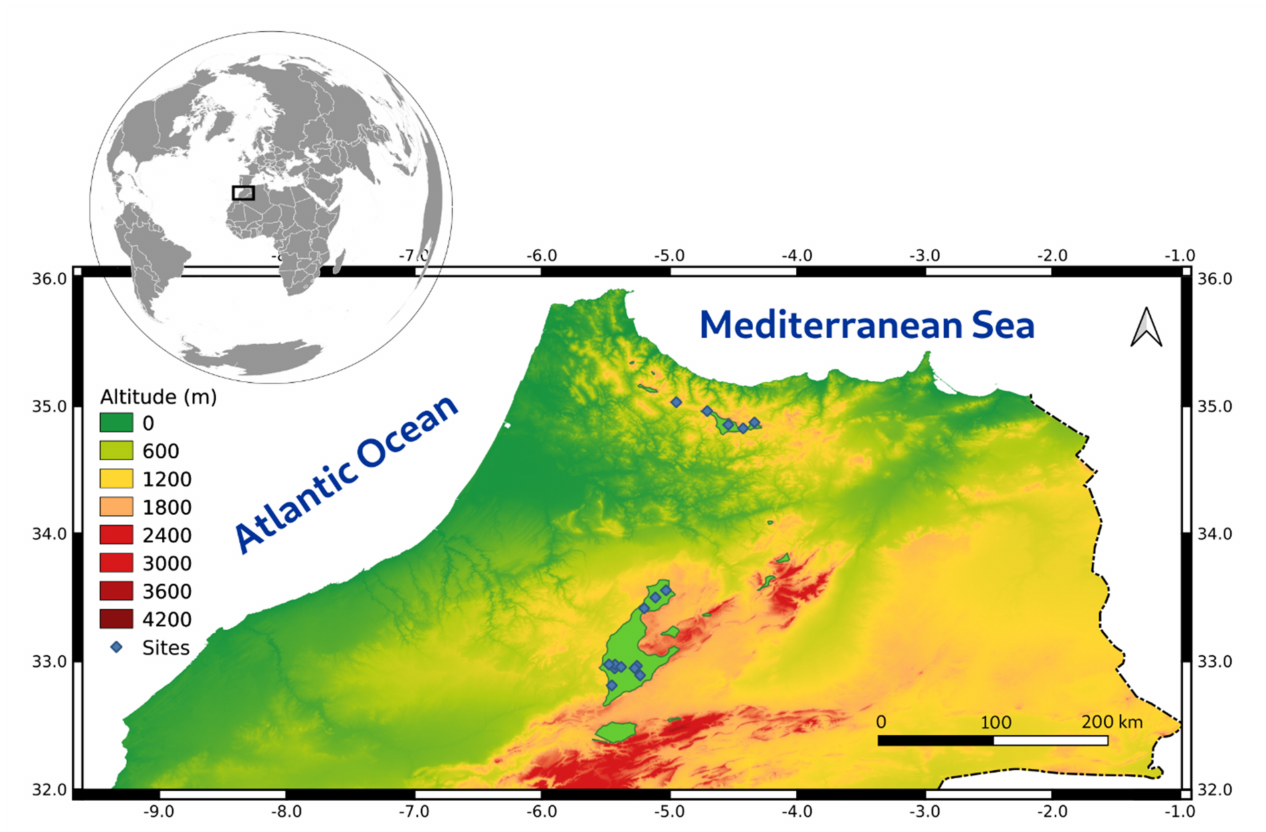
Figure 1. Northern Morocco with the border of Algeria (on the right), extant distribution of the Atlas cedar (light green areas) and sampling locations (blue